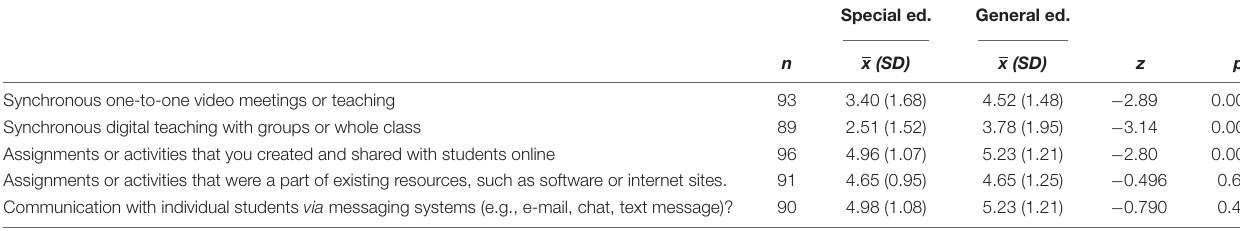
TABLE 3 | Teachers’ reported use of distance learning approaches in special and general education and results of pairwise comparisons.